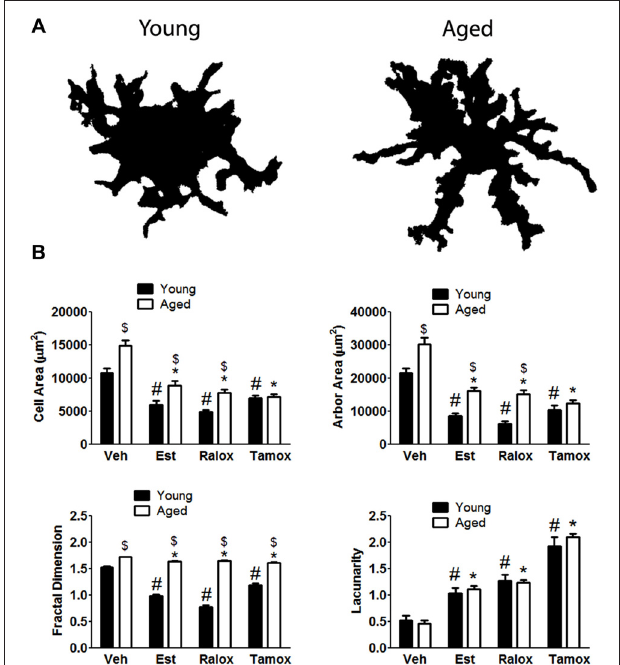
FIGURE 4 | (A) The upper panel indicates age differences on microglia morphology with aging in animals treated with vehicle. Fractal analysis shows that microglia reactivity is characterized by changes in both cell body and processes. (B) Cell shape is hypertrophied and bushier in control cells (vehicle, V) compared to those cells from animals treated with estradiol (Est), raloxifene (Ralox) or tamoxifen (Tamox). * P < 0.05 vs. vehicle (young); # P < 0.05 vs. vehicle (aged); $ P < 0.05 young vs. aged treated with same